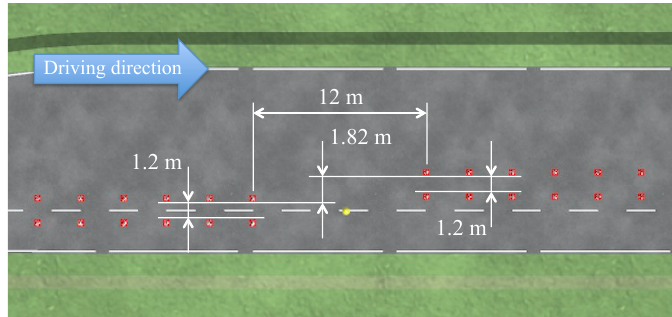
Figure 20. Single lane change course as obstacle avoidance.